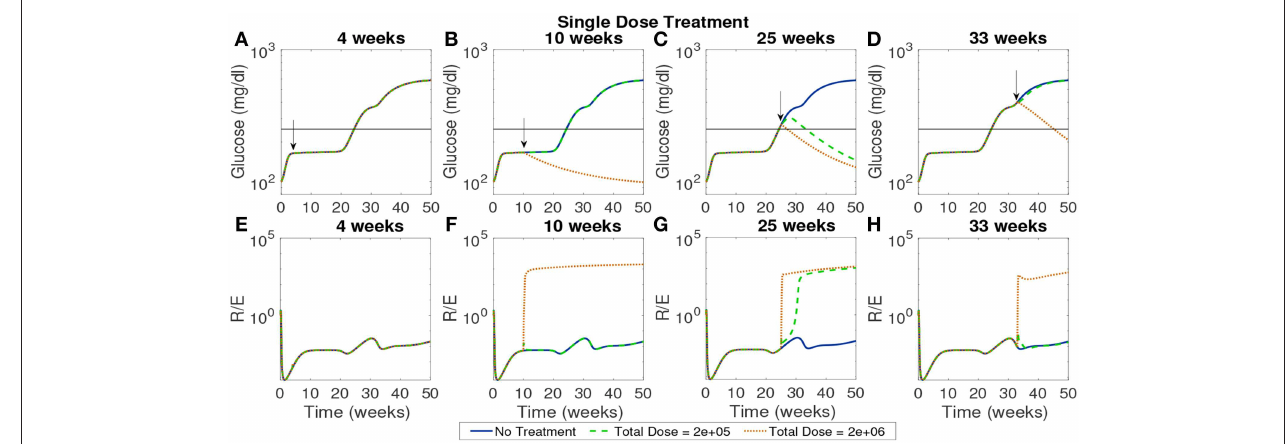
FIGURE 9 | The NOD mouse model simulated with a single dose of tolerogenic DCs administered in a single injection, for varying dose amounts and treatment start times. (A–D) Glucose levels for all treatment levels. (E–H) Ratio of regulatory to effector T cells for all treatment levels. (A) Treatment is ineffective when started too early for any dose amount. In all cases, T cell ratios indicate larger values of effectors to regulatory cells when treatment is not effective. (B) Only high doses are effective when started at the 10 week mark in the pre-diabetic range. (C) Both treatment amounts are effective right after glucose threshold is exceeded, as indicated by low terminal glucose levels and high T regulatory cell levels. (D) Treatment can be effective when started after the development of the disease, but larger doses are required.